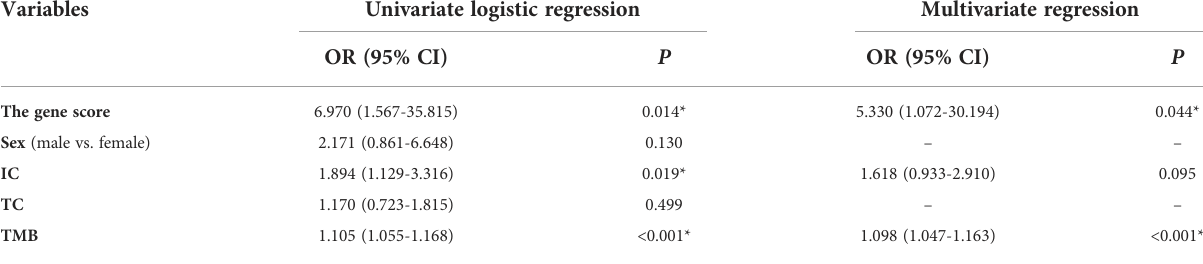
TABLE 2 Univariate logistic regression analysis of the gene score and clinical candidate predictors in the training set.